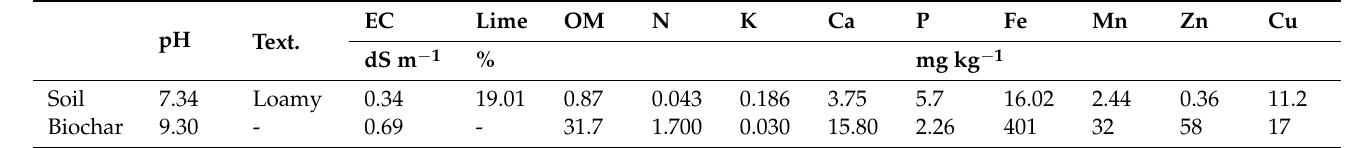
Table 1. Physical and chemical analysis results of soil and biochar used in the experiment.